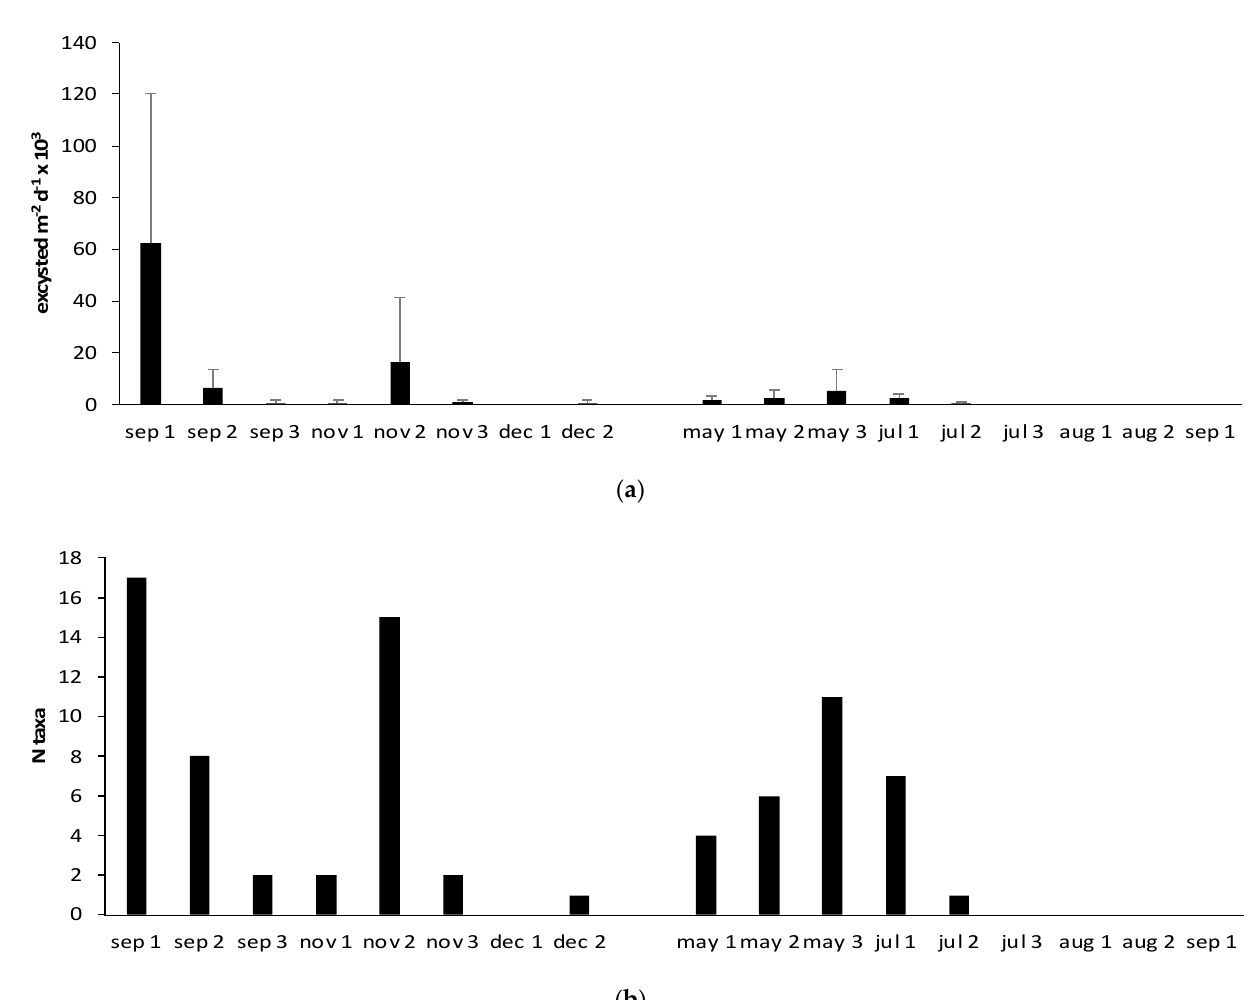
Figure 7. Active stages collected with inverted traps on the floor of the Mar Piccolo of Taranto. ( a ) Abundance (average ± SD); ( b ) taxa richness.